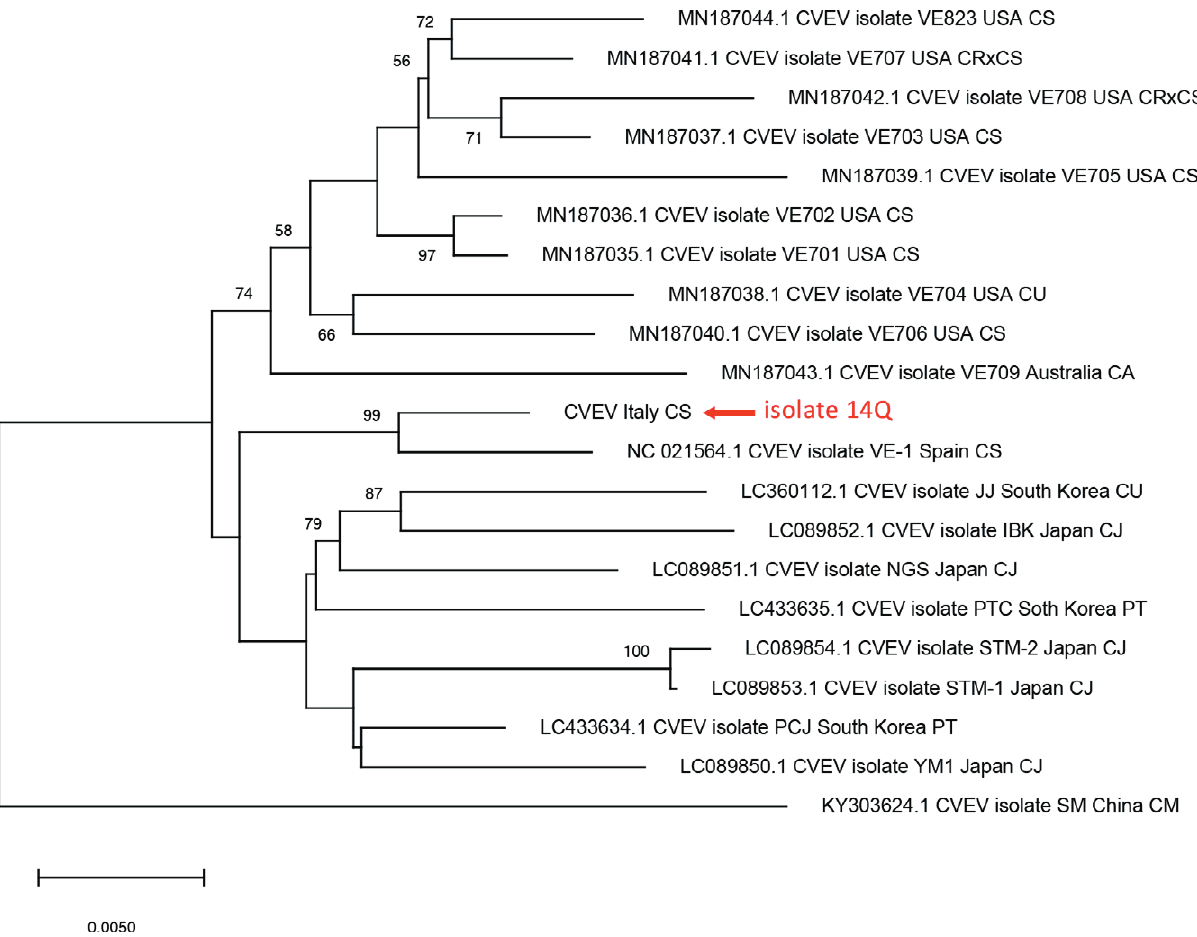
Figure 3. Phylogenetic tree generated using all the full-length CVEV genome sequences available in databases and the CVEV-14Q isolate. Clustal omega alignment of the nucleotide sequences was used for inferring the phylogenetic tree using the Maximum likelihood method, and adopting the best-fit model kimura 2+G using MEGA7. Bootstrap probability values (1000 replicates) greater than 50% are shown at the branch nodes. Tree branches are proportional to the genetic distances, with the scale bar indicating substitutions per nucleotide site. The accession number, isolate name, country of origin and citrus host ( Citrus junos , CJ; C. maxima , CM; C. reticulata , CR; C. sinensis , CS; C. unshiu , CU; Poncirus trifoliata , PT) are shown at each branch